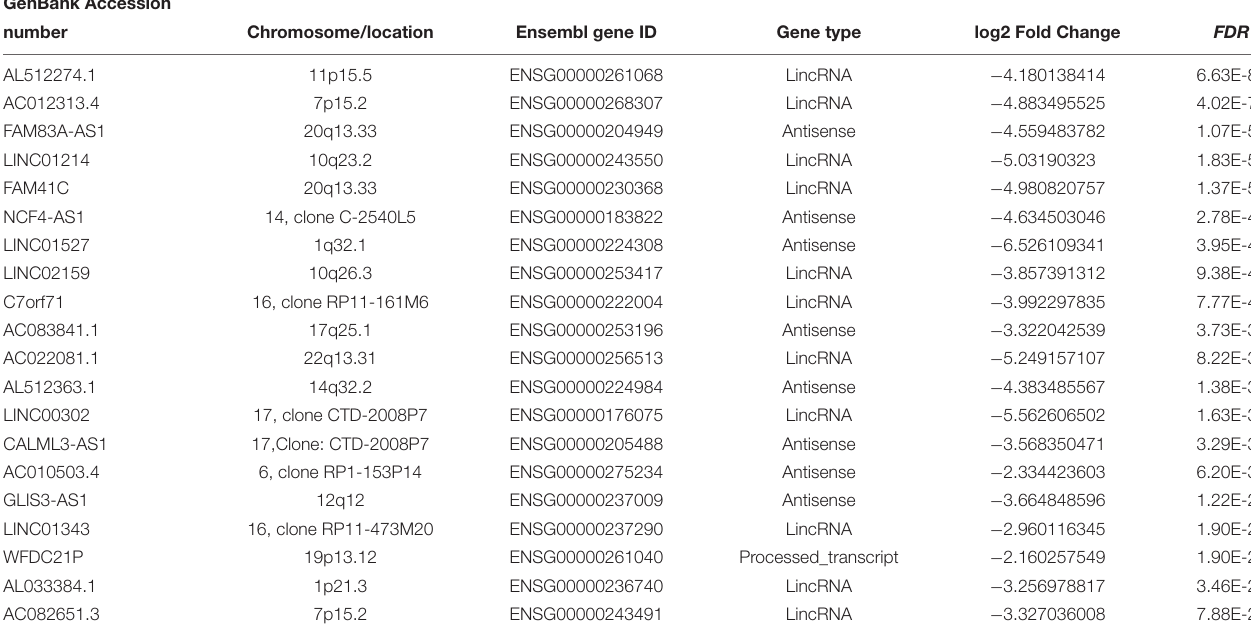
TABLE 2 | The top 20 downregulated DElncRNAs in metastatic melanoma ( p <